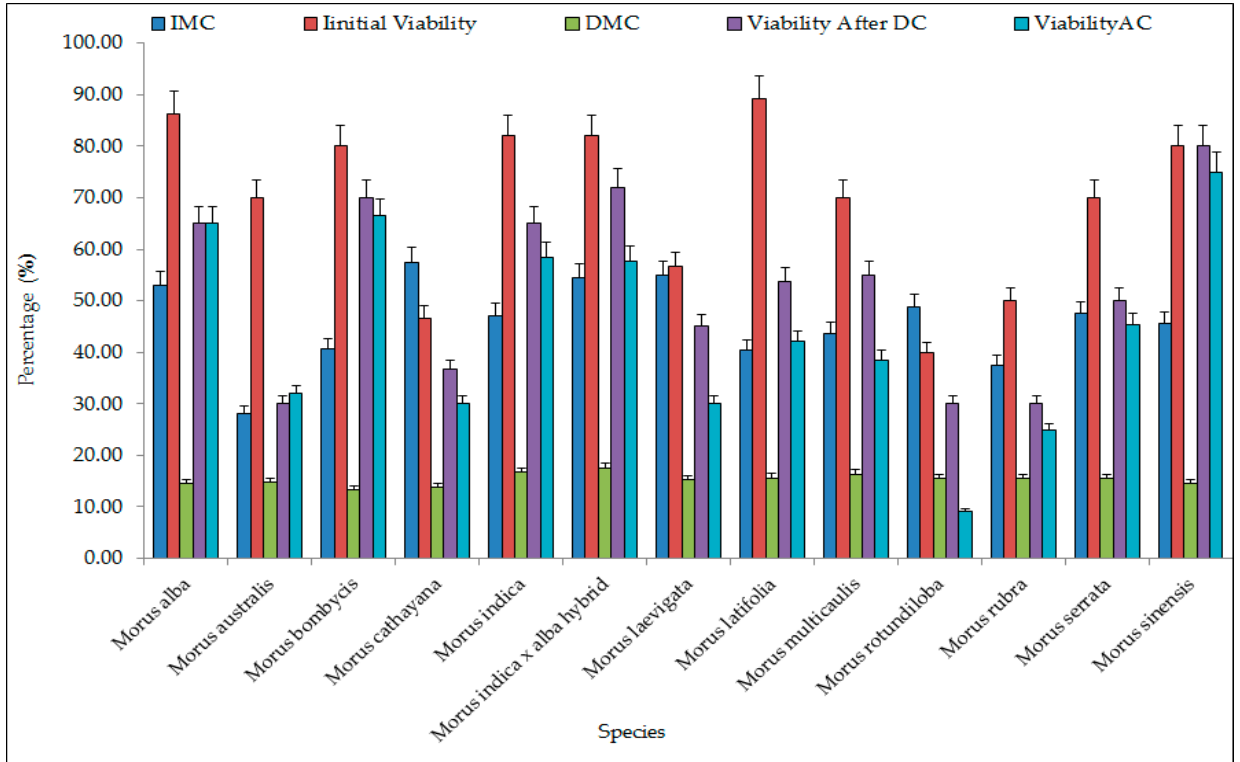
Figure 2. Viability of dormant buds of different Morus species after cryostorage. Error bars showing mean values ± SD (n = 3). (IMC = initial moisture content; DMC = moisture content after desiccation; DC = desiccation; AC = after cryopreservation).